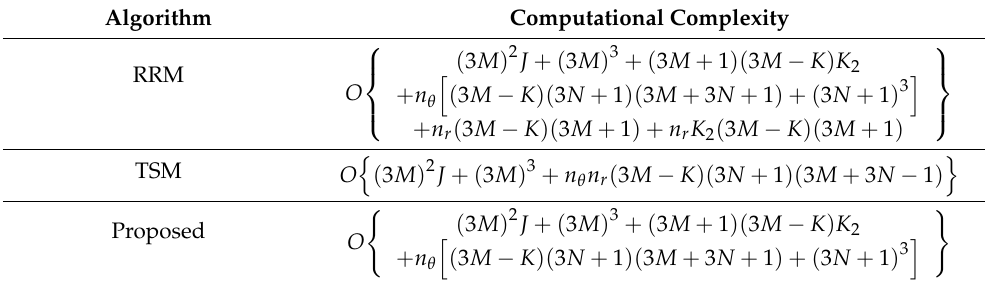
Table 1. Computational complexity of different algorithms.